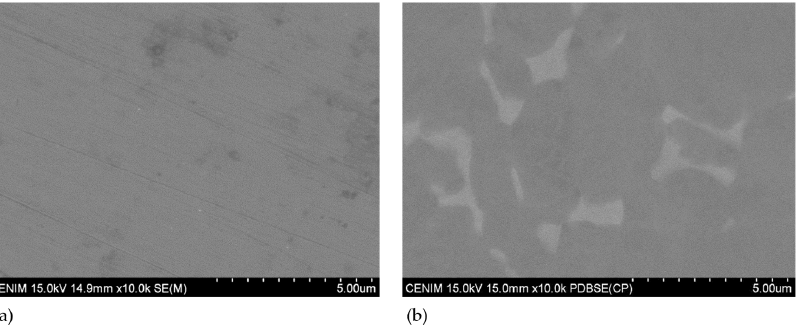
Figure 1. SEM appearance of ( a ) mechanical CoCrMo alloy polishing and ( b ) chemical-mechanical Ti6Al4V alloy polishing after surface preparation.